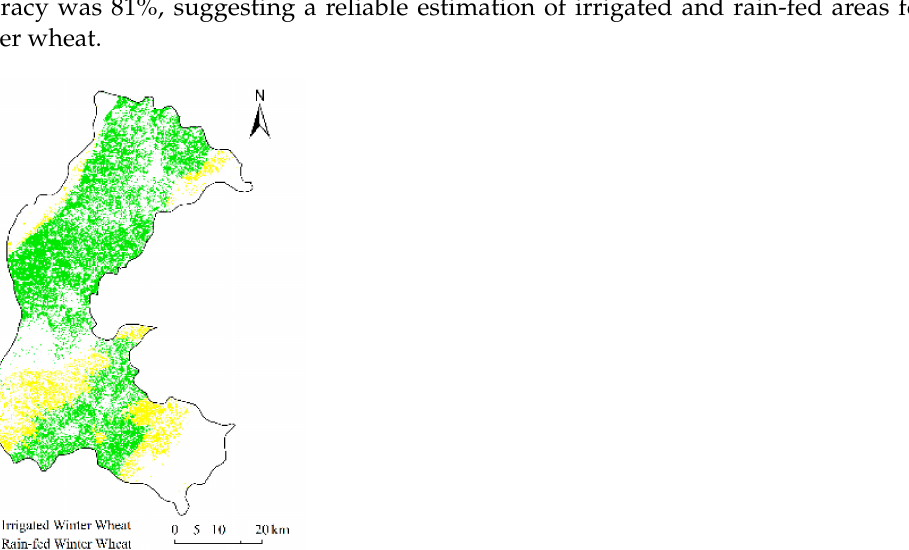
Figure 2. Spatial distribution of irrigated areas and rain-fed areas for winter wheat in Xiangfen, Xinjiang, and Wenxi county.